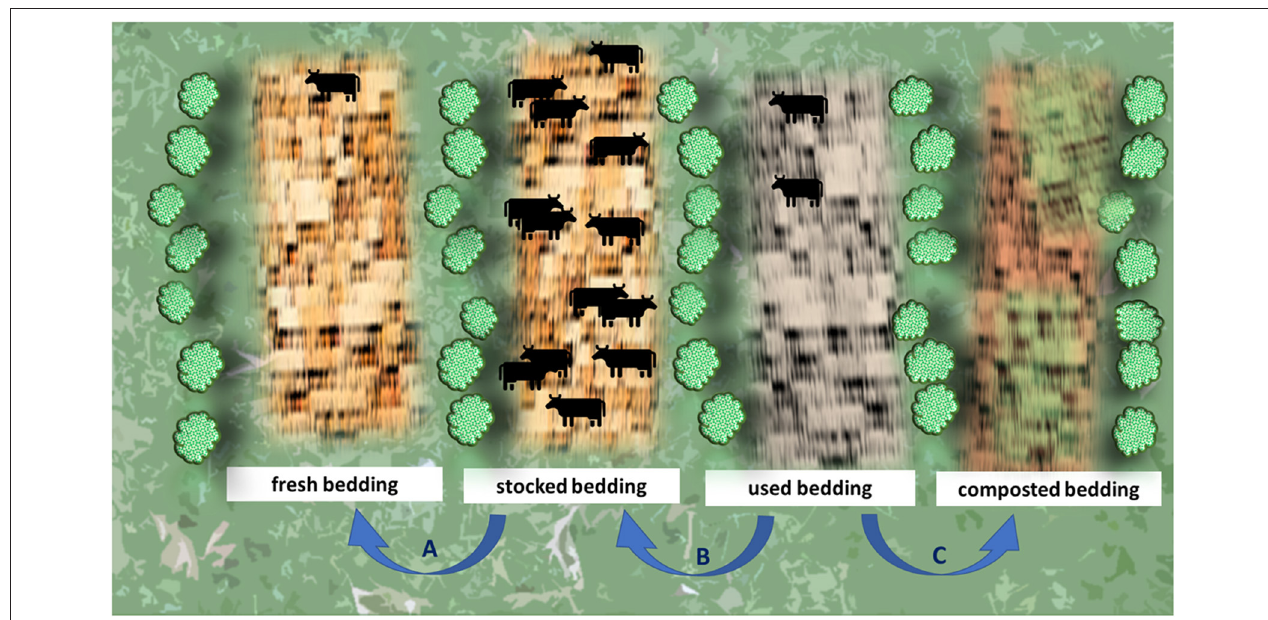
FIGURE 2 | Temporary stand-off bedding in a silvopastoral scenario. Livestock are moved sequentially from one temporary pad to the next (A,B) once a pad becomes fully loaded with water or animal wastes. The used bedding material will be subject to composting processes (C) for subsequential use within the farm